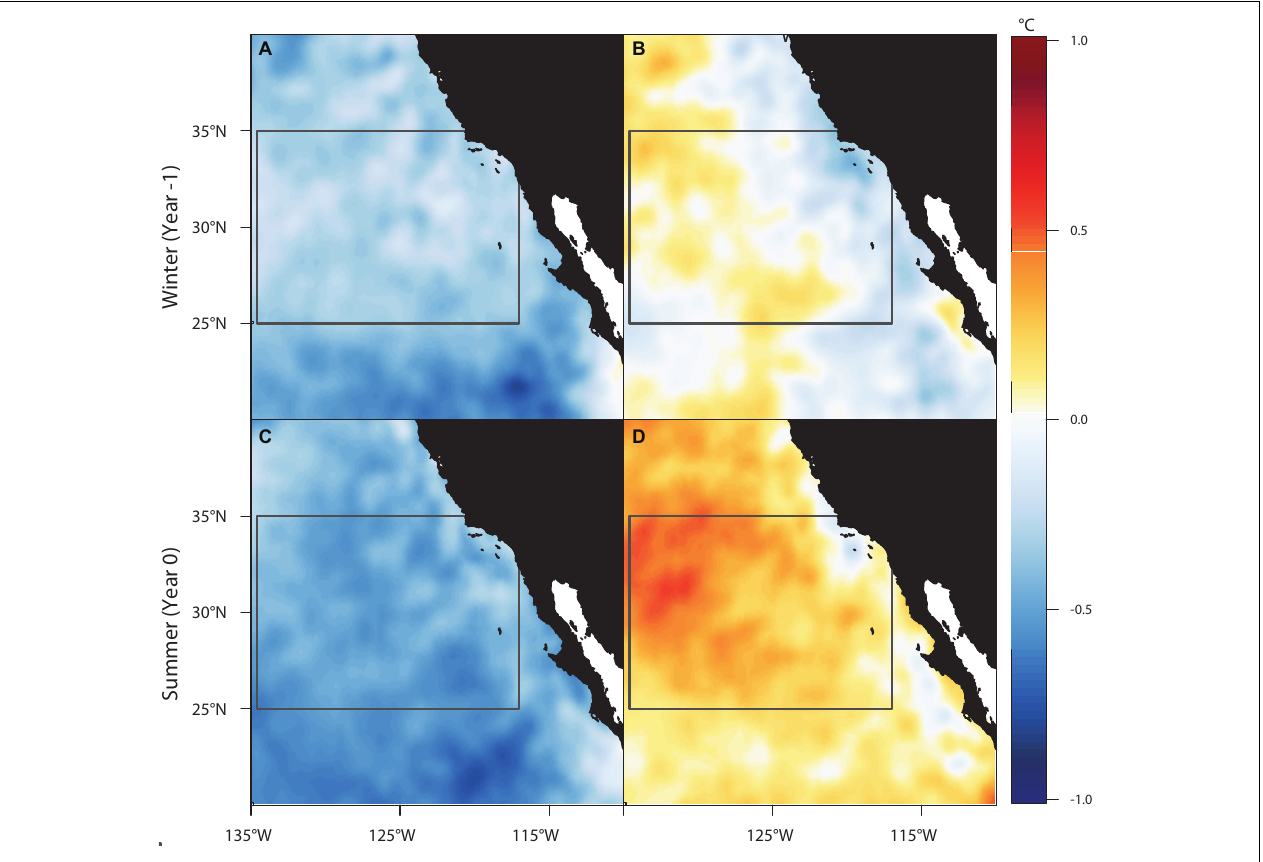
FIGURE 4 | Six-month mean spatial composites of monthly SST anomalies for cool (A,C) and warm (B,D) ocean conditions during recruitment year summers (Apr-Sep, Year 0) and their preceding winters (Oct-Mar, Year -1). The region utilized by the six easternmost transiting juvenile loggerhead sea turtles is outlined in gray and represents the location of a thermal corridor that may facilitate the successful recruitment to coastal foraging